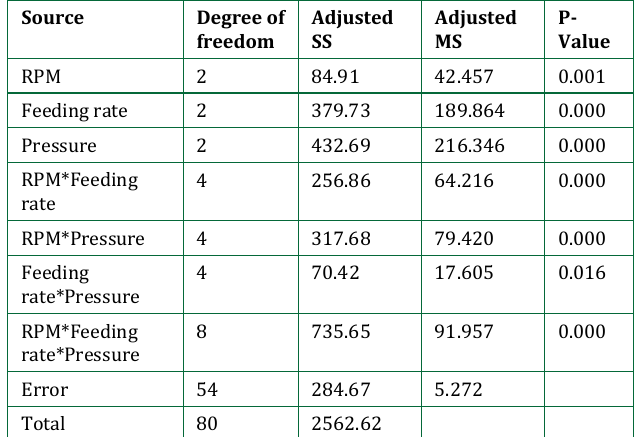
Table 2: Analysis of variance (ANOVA) for composting